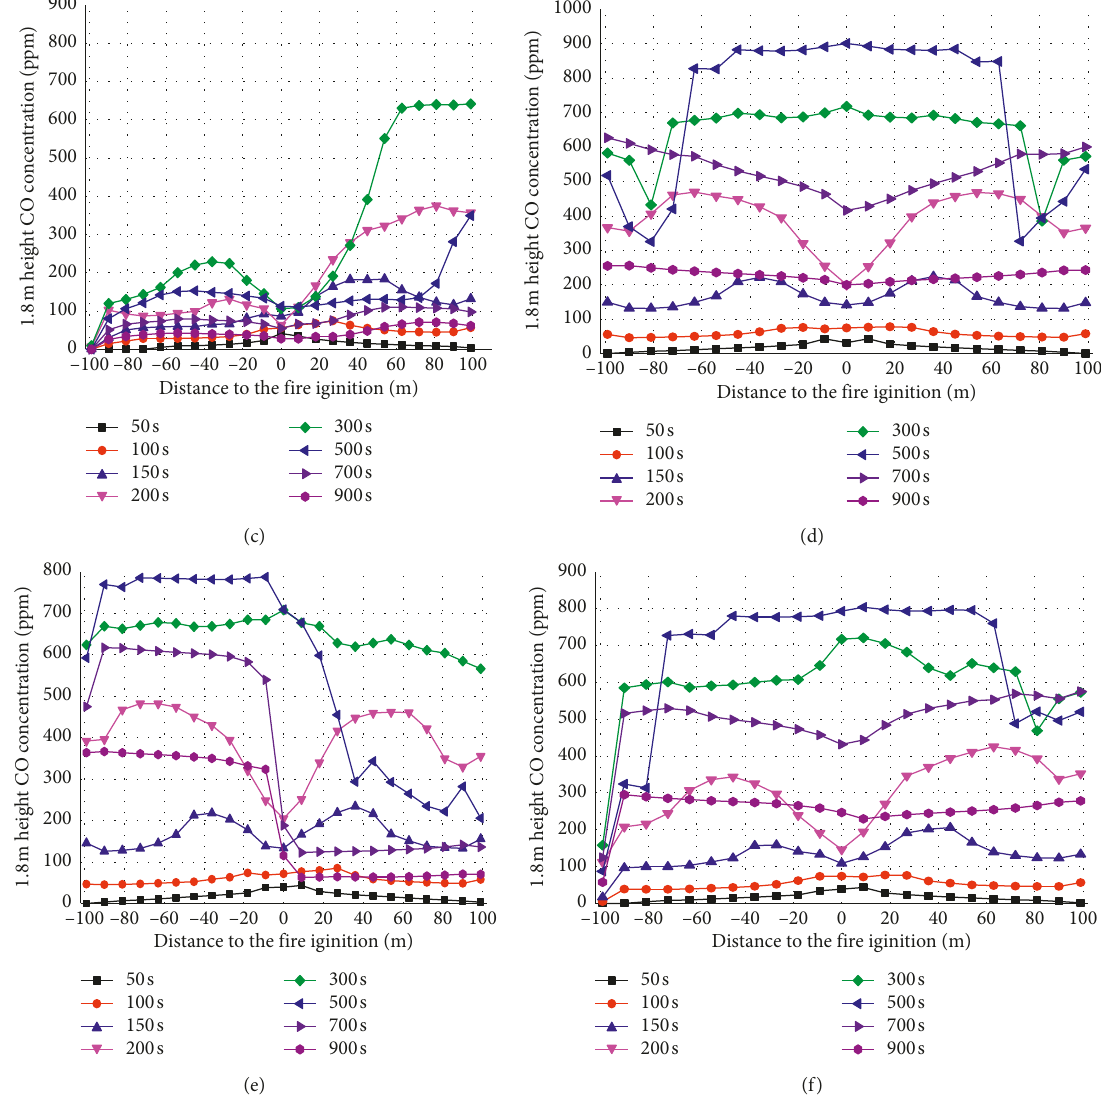
Figure 11: CO concentration at 1.8m height along the tunnel with different time. (a) FS1. (b) FS2. (c) FS3. (d) FS4. (e) FS5. (f)